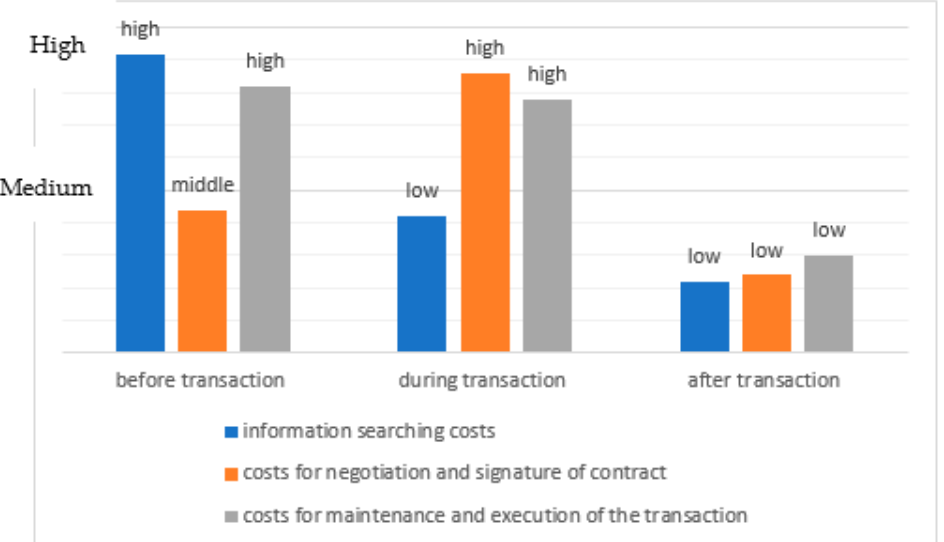
Figure 2. The transaction costs at different stages in the “homestead replacement” model in Jinzhai .